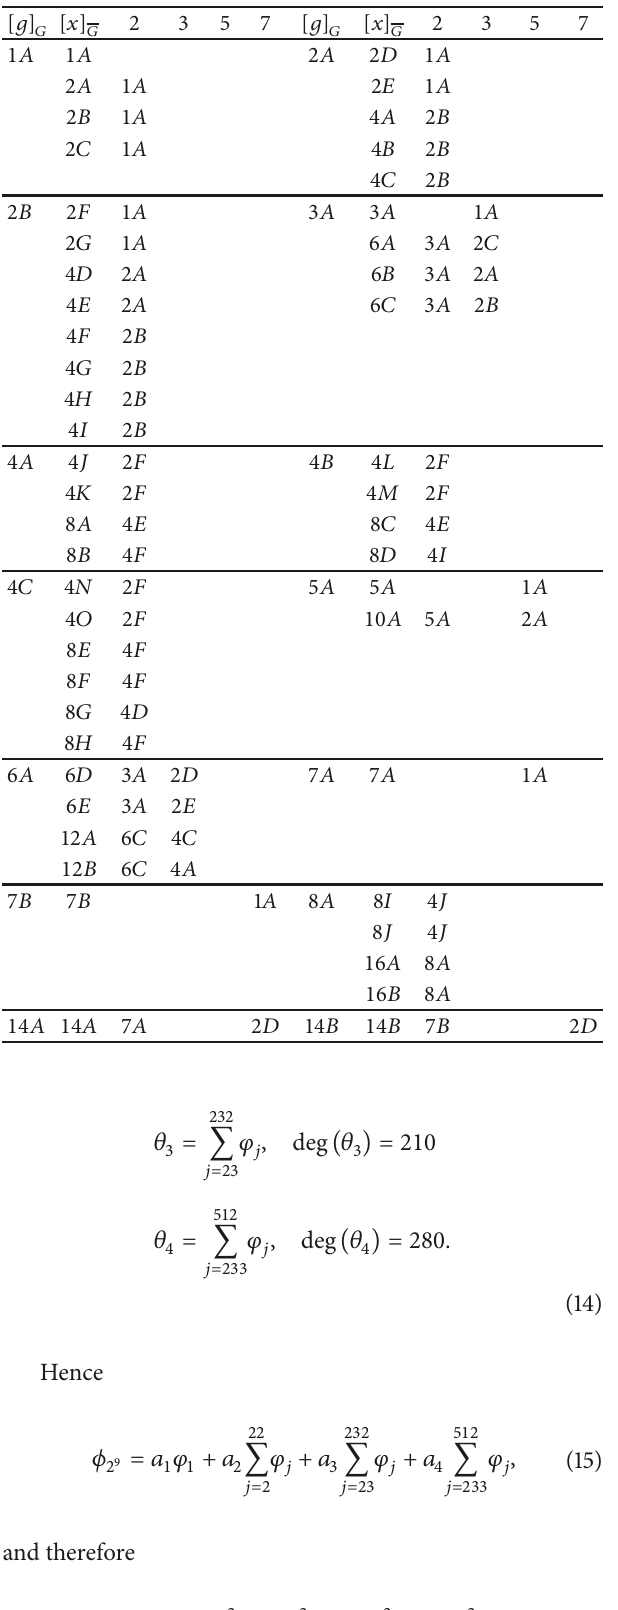
Table 8: The power maps of the elements of 2 9 : (𝐿 3 (4) : 2) . [𝑔] [𝑥] 𝐺 𝐺